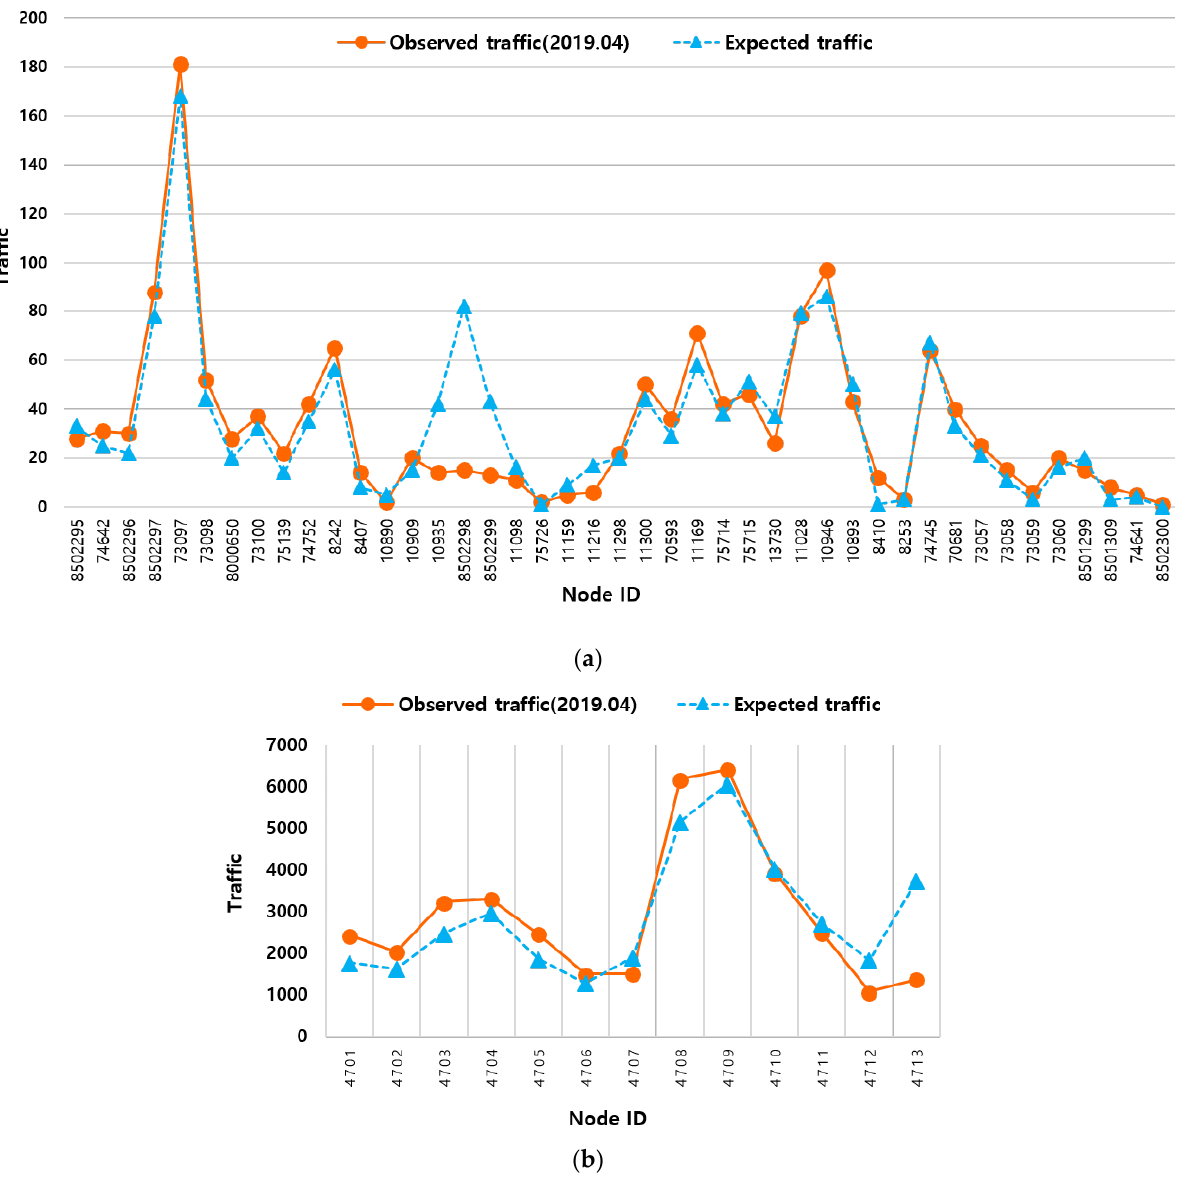
Figure 8. Daily average number of passengers per node: ( a ) bus No. 1167; ( b ) Ui-Sinseol subway line.